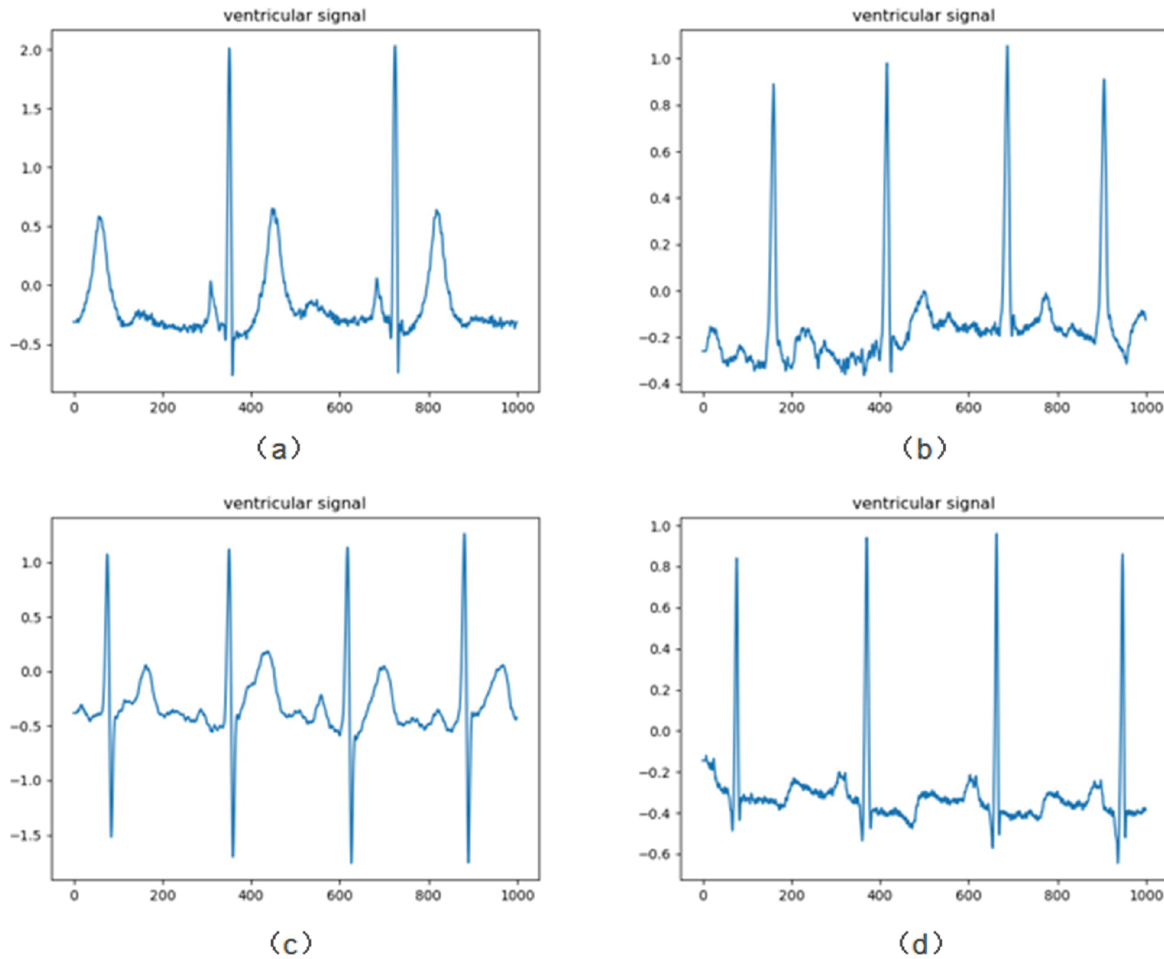
Fig 2. (a-d) ECG plotted for the first 1000 data of the